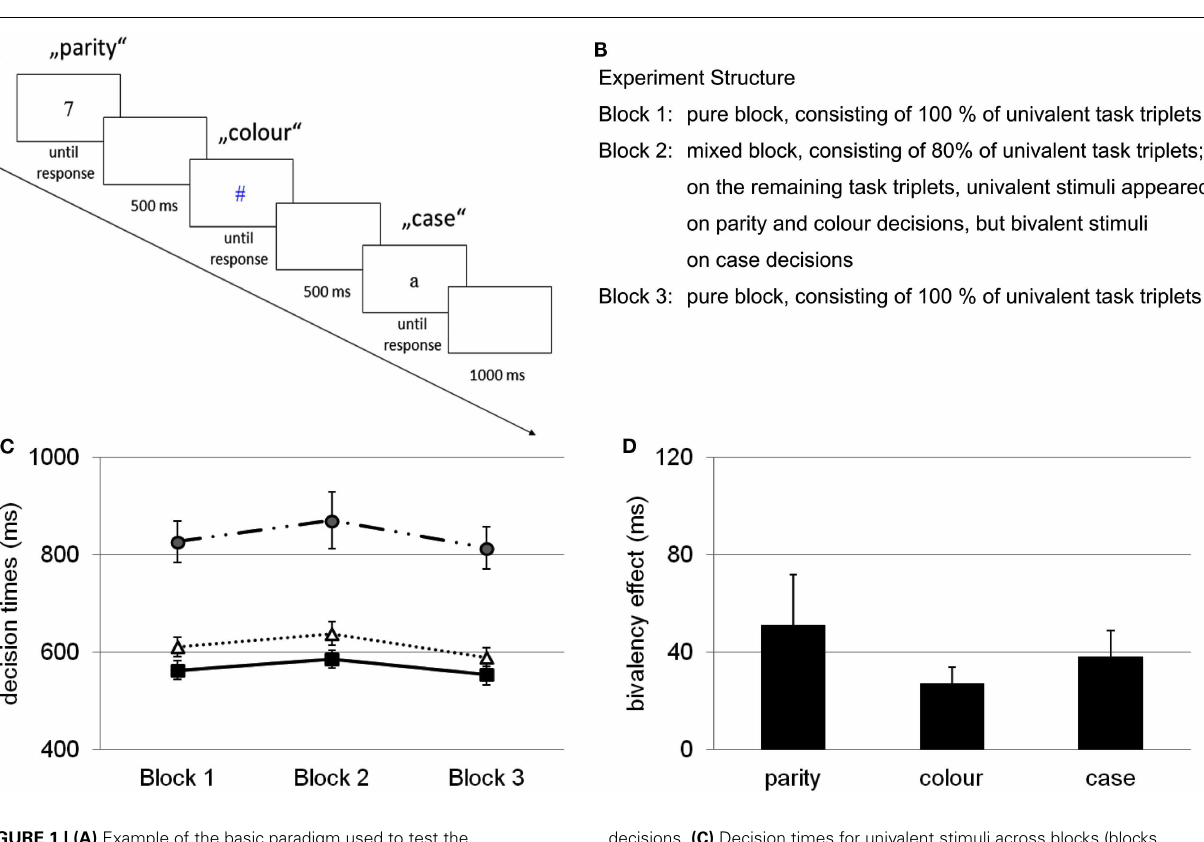
decisions. (C) Decision times for univalent stimuli across blocks (blocks 1 and 3 pure, block 2 mixed), on parity decisions (circles), color decisions (squares), and case decisions (triangles). (D) Bivalency effect, expressed as performance difference on univalent stimuli between block 2 and blocks 1 and 3 averaged. Error bars represent standard errors. Adapted fromWoodward et al.